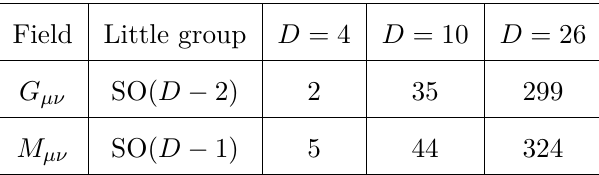
Table 1 . Propagating dof in various